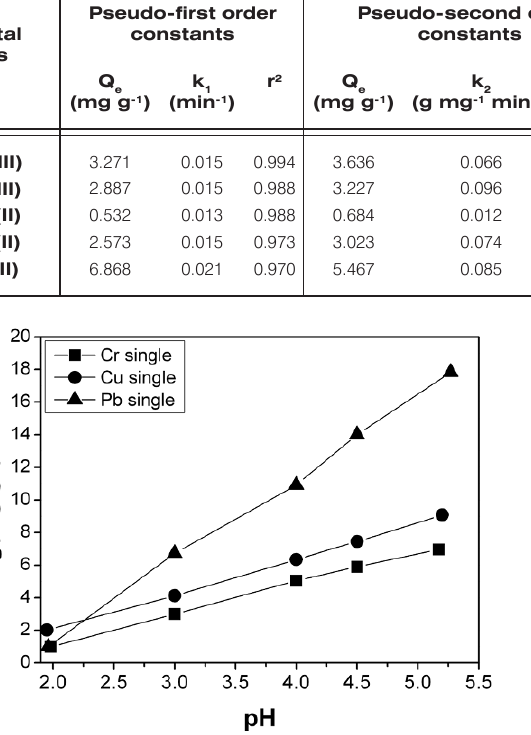
Figure 6. Effect of pH on metal adsorption onto Si-10Al